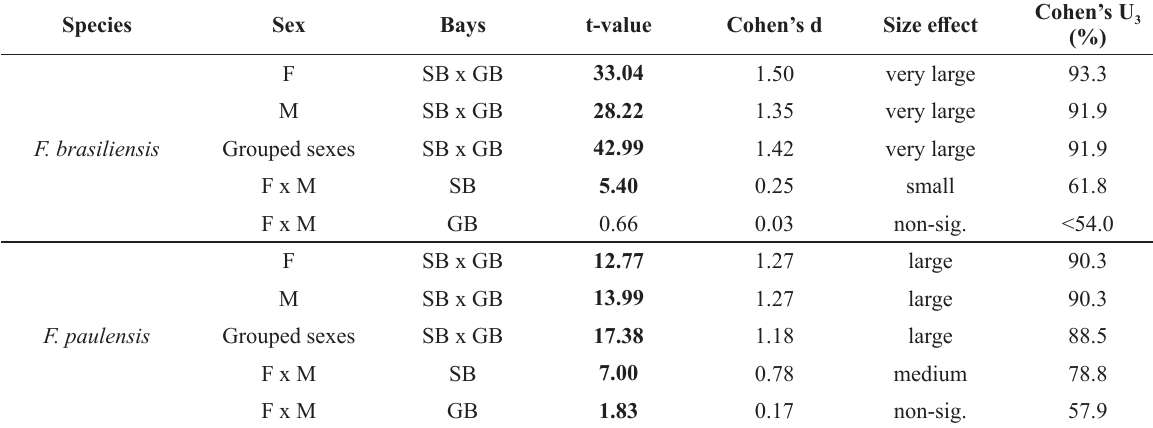
Comparisons of b values (TL=a+b.CL) for each sex, species ( F. brasiliensis and F. paulensis ) and bay.